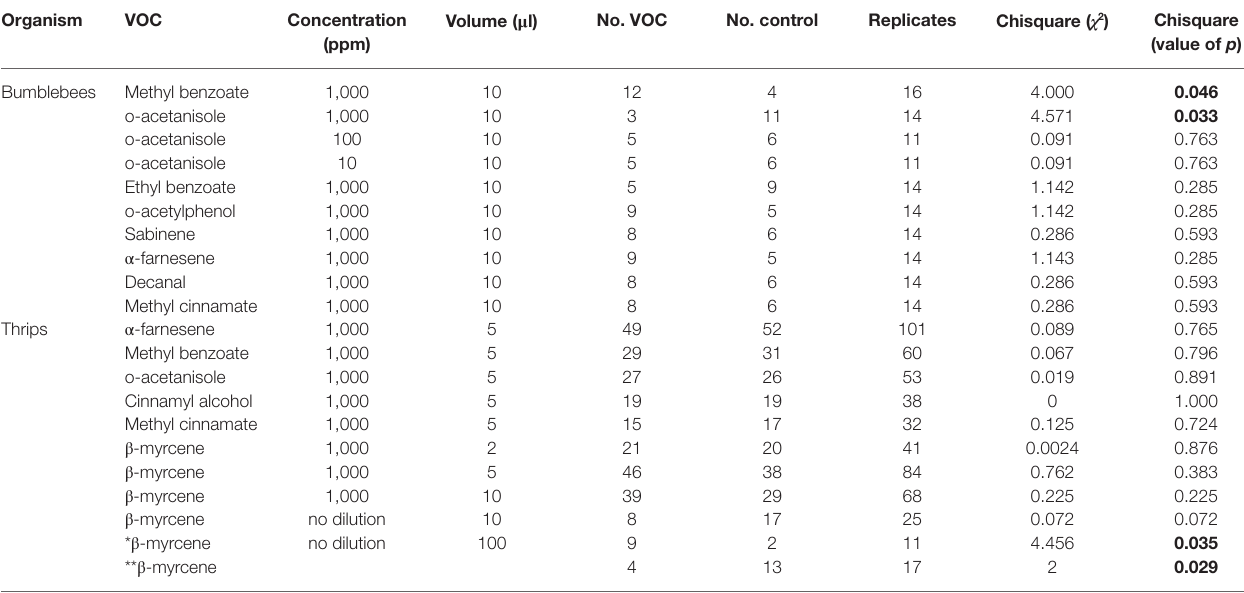
TABLE 2 | Effect of isolated VOCs tested with each organism, at indicated concentrations.